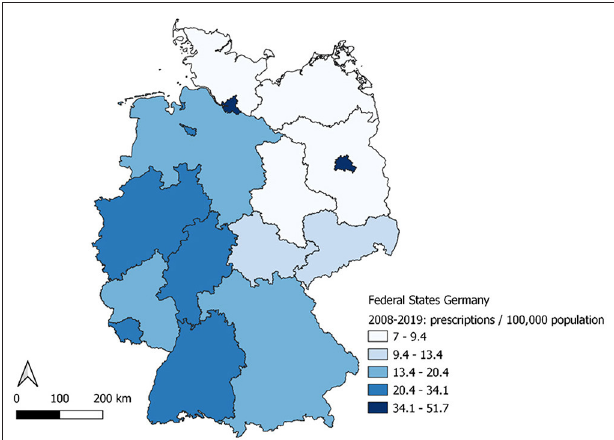
FIGURE 3 | Prescriptions per 100,000 population by Federal State, Germany,